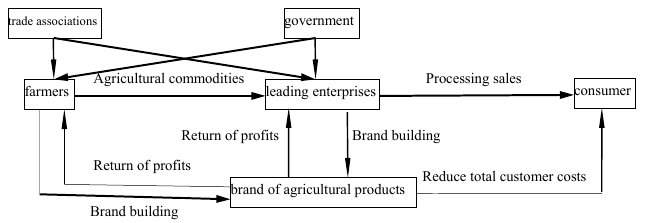
Figure 1: Agricultural brand construction and development